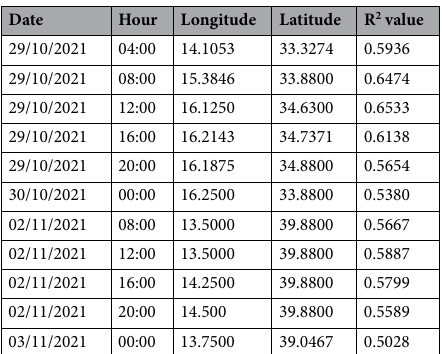
Table 1. Main feature of the microseism source located in the two time intervals that show R 2 values greater than 0.5.